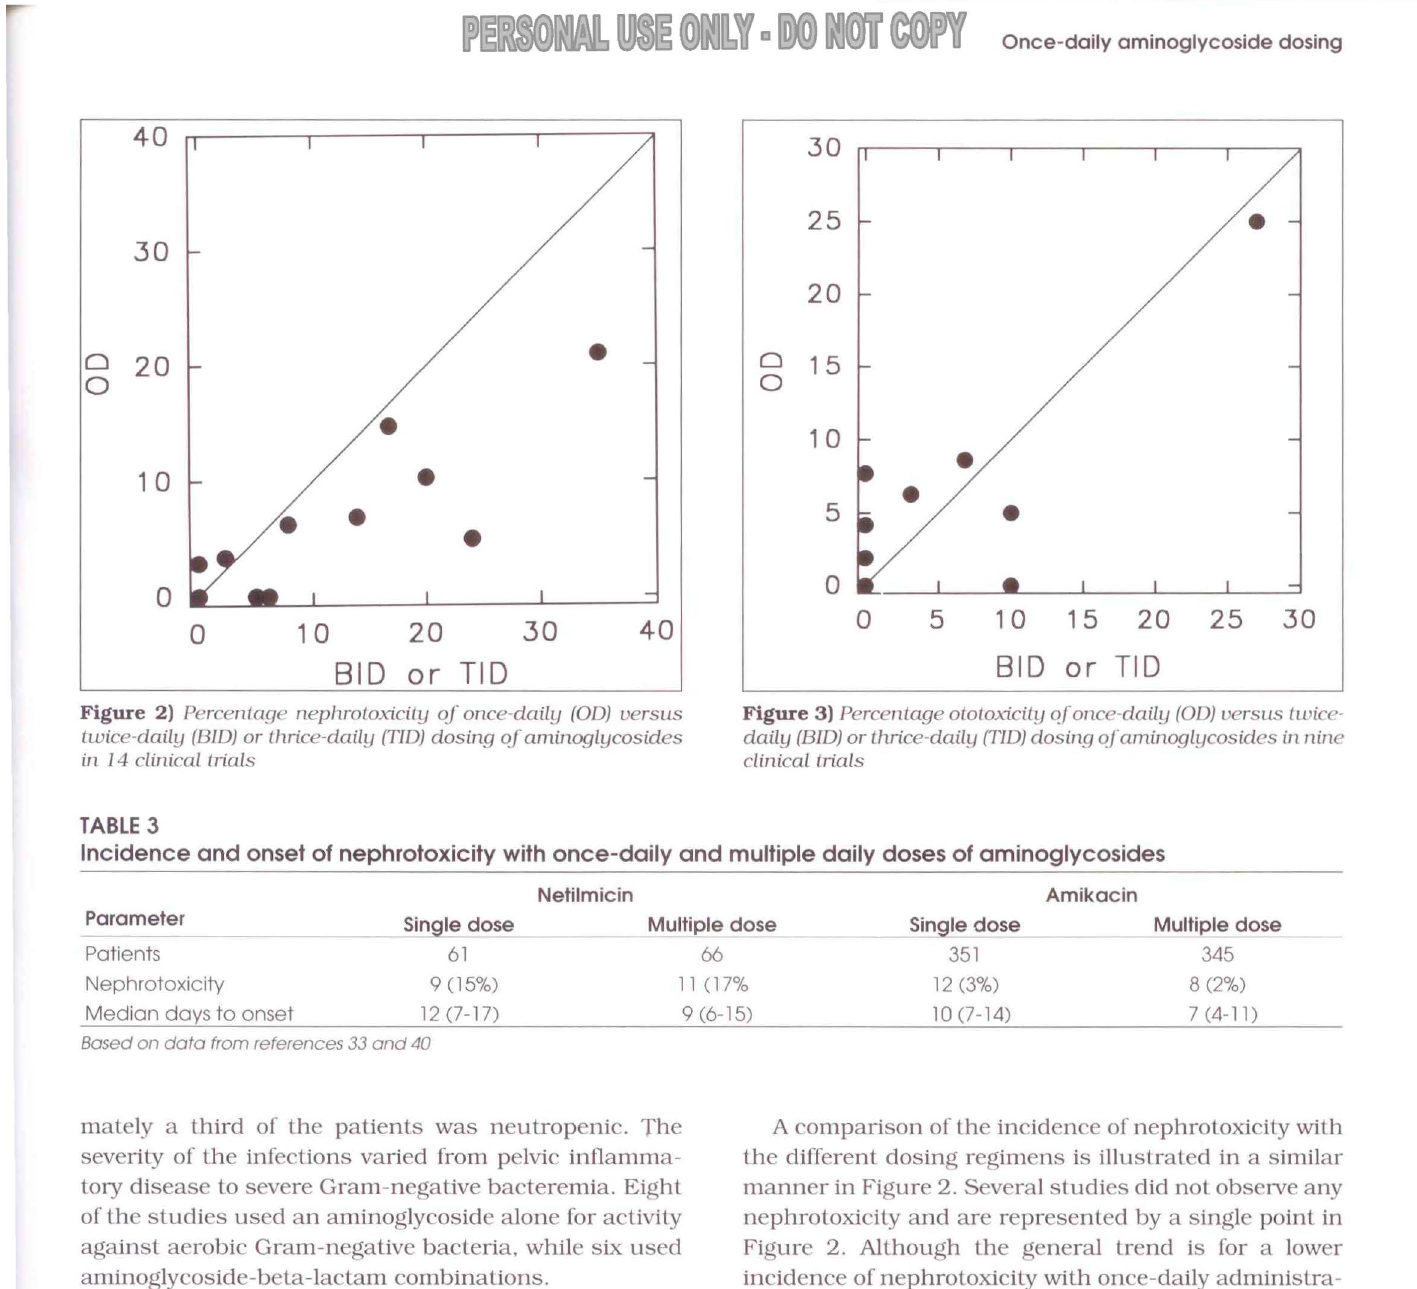
Figure 2) Percentage nephrotoxicity of once-daily (OD) versus twice-daily (BED) or thrice-daily (TIDJ dosing of aminoglycosides in 14 clinical trials